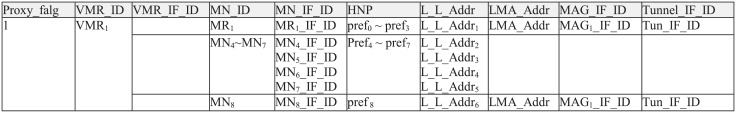
The updated BUL at the MAG.